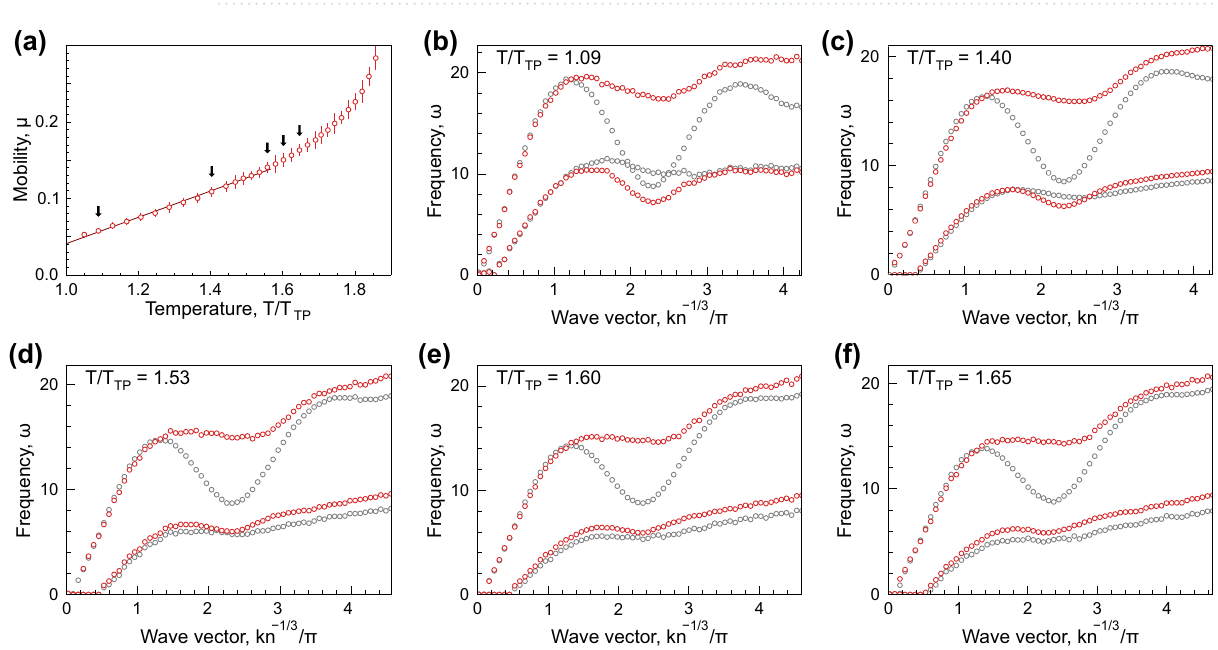
Figure 3. Particle mobility and excitation spectra: ( a ) Temperature dependence of the mobility coefficient in LJ12-6 system at the liquid branch of the gas-liquid binodal. Black arrows indicate the temperatures, at which the excitation spectra shown in panels ( b )–( f ) were calculated. ( b )–( f ) excitation spectra in LJ12-6 fluid at the liquid–gas binodal; spectra obtained using the single mode (longitudinal and transverse) analysis are shown with gray symbols; spectra obtained using the two-oscillator model (high- and low-frequency hybridised modes) are shown with red symbols. The reduced temperatures are indicated in the upper left